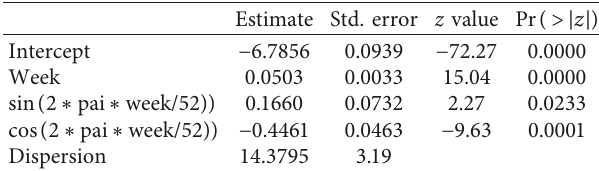
Table 5: Model summary. Estimate Std. error z value Pr